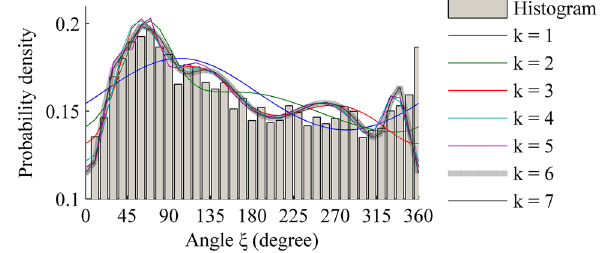
Figure 4. Histogram of circular variable ξ . A voM mixture model with six-component distributions fits the histogram of circular variable well in all candidate model with different components. Figure created using Matlab R2014a (https:// www. mathw orks. com).